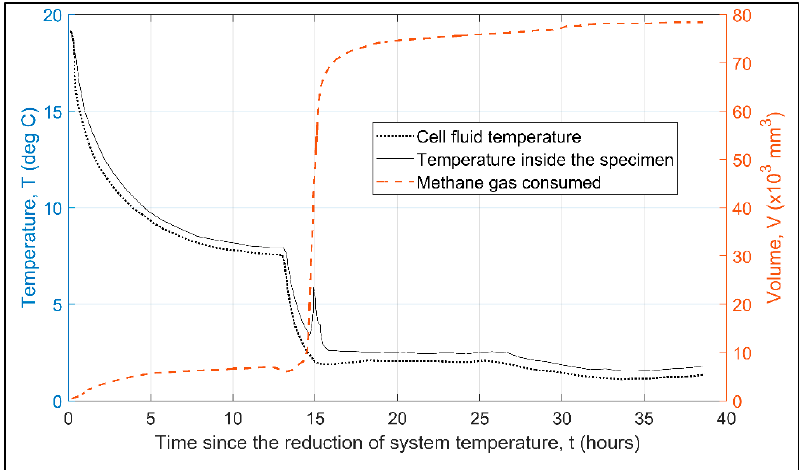
Figure 5. Change in temperature measured for specimen HFT, along with methane gas consump- tion, with time over the hydrate formation stage. The rapid increase in methane consumption once hydrate formation is initiated is followed by a temperature spike inside the specimen due to exo- thermic nature of hydrate formation.